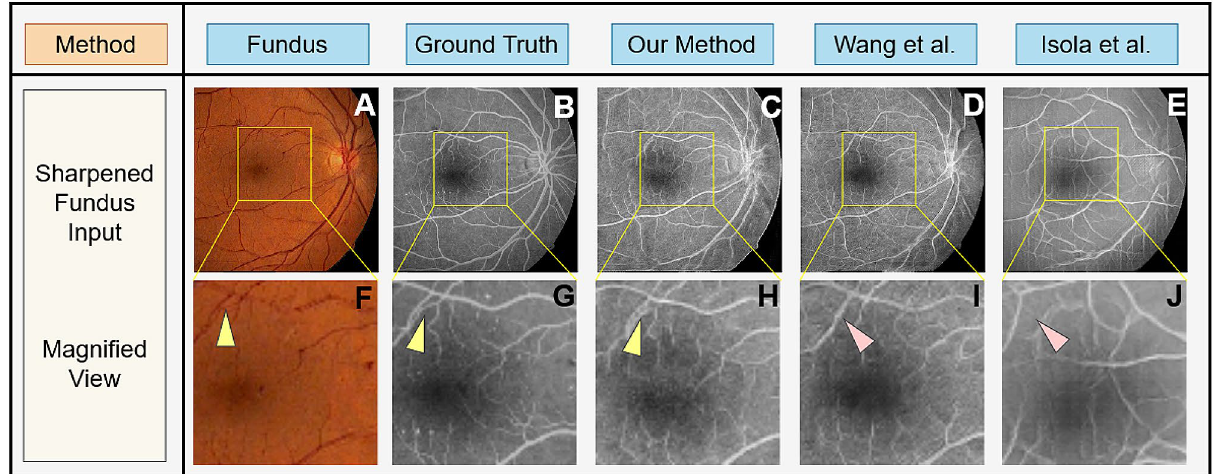
Figure 8. Paired color sharpened fundus photographs ( A ) and ground truth FA images ( B ). FA images generated by our proposed method ( C) and those generated by traditional GANs proposed by Wang et al. ( D ) 50 and Isola et al. ( E ) 27 . Subfigures ( F–J ) show magnification of the yellow boxed areas from ( A–E ). Microvascular structures are not quite visible in the fundus photographs ( A,F ), but are visible in the original FA images ( B,G ) pointed to by the yellow triangles. Our deep learning GAN is capable of producing these microvascular structures pointed to by the yellow triangle, as well as macro vascular structures ( C,H ). The GAN proposed by Wang et al. 50 misses these microvascular structures ( D,I ) while GAN proposed by Isola et al. 27 is not able to produce any reliable vascular structure ( E,J )—see red